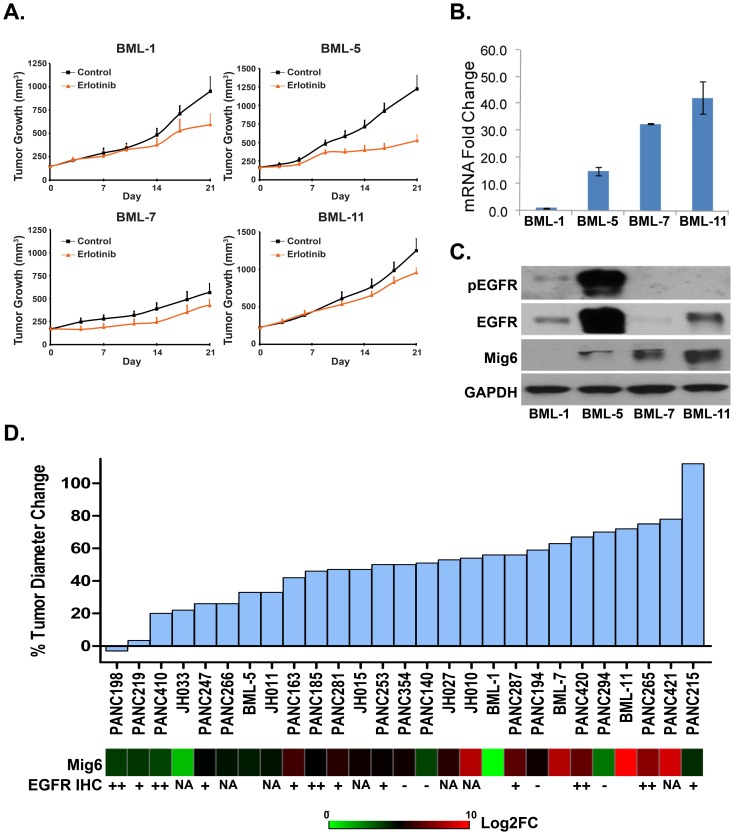
Mig6 expression correlated with erlotinib response in directly xenografted low passage lung and pancreatic tumors.
A) Effect of erlotinib on growth of directly xenografted lung tumors. Data are plotted as mean ± SEM. B) Real-time PCR of Mig6 on directly xenografted tumors. Data are plotted as mean ± SD after normalization with GAPDH. C) Immunoblot analysis of protein lysates of lung xenografts. D) Efficiency of erlotinib in inhibiting growth of tumor xenografts was displayed from most sensitive (left) to most resistant (right) as a bar graph. Relative expression of Mig6 in each tumor xenograft is displayed underneath the tumor growth inhibition bar as a heatmap. FC: fold change. Scale used was Log2FC.